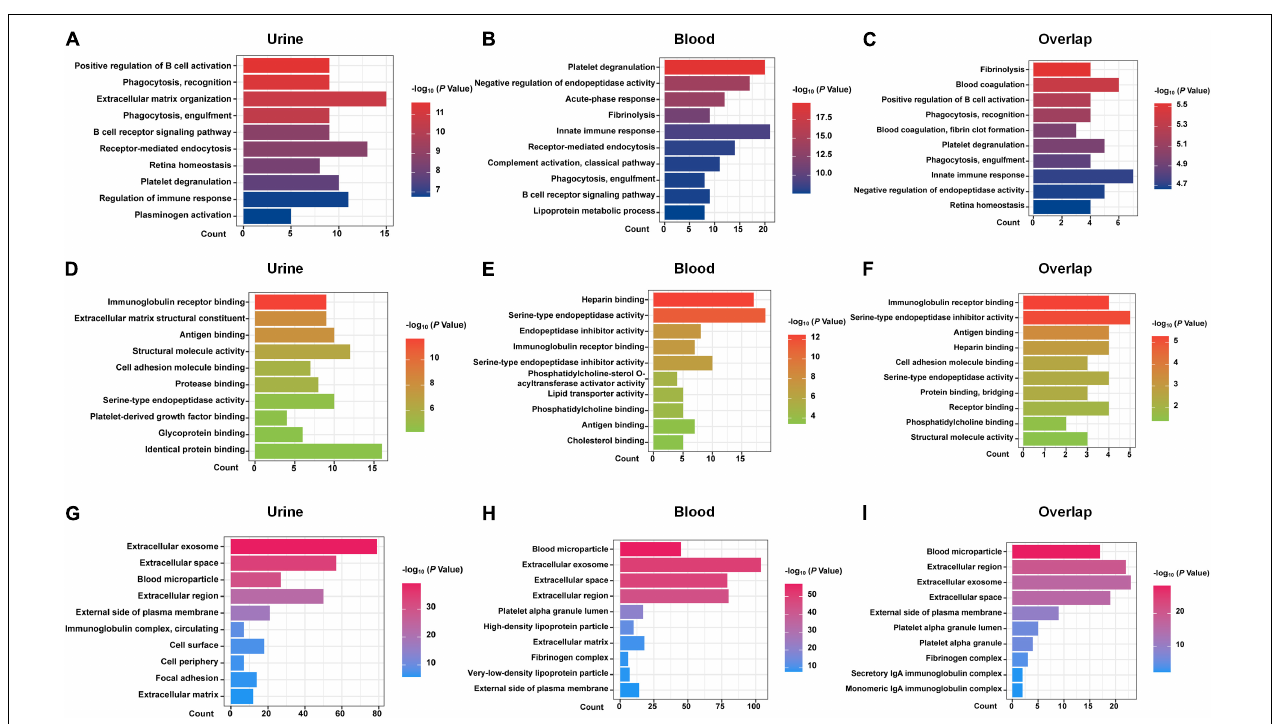
Frontiers in Medicine |